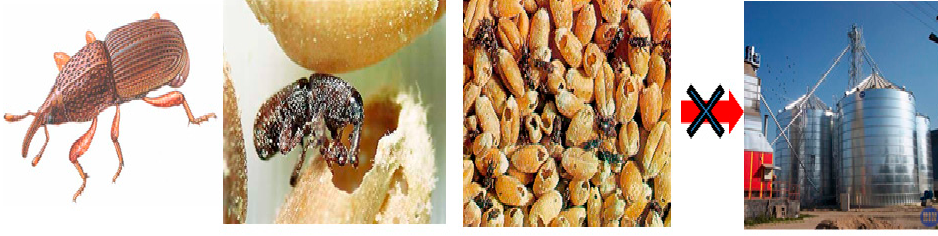
Figure 1. Grain weevil ( Sitophilus granarius L.) in the context of the grain storage process [16]. Young individuals are light-brown, whereas adults are dark. The body length of grain weevils ranges from 2 to 5 mm. Most often grain weevils hide in small cracks and avoid sunlight. Grain weevils are characterized by their high resistance to hunger. At a temperature of about 12 °C, a grain weevil can survive 115 days without food. A female grain weevil makes a hole in grain and deposits from grain. The sealed hole made by the pest is not visible with the naked eye. Grain weevils